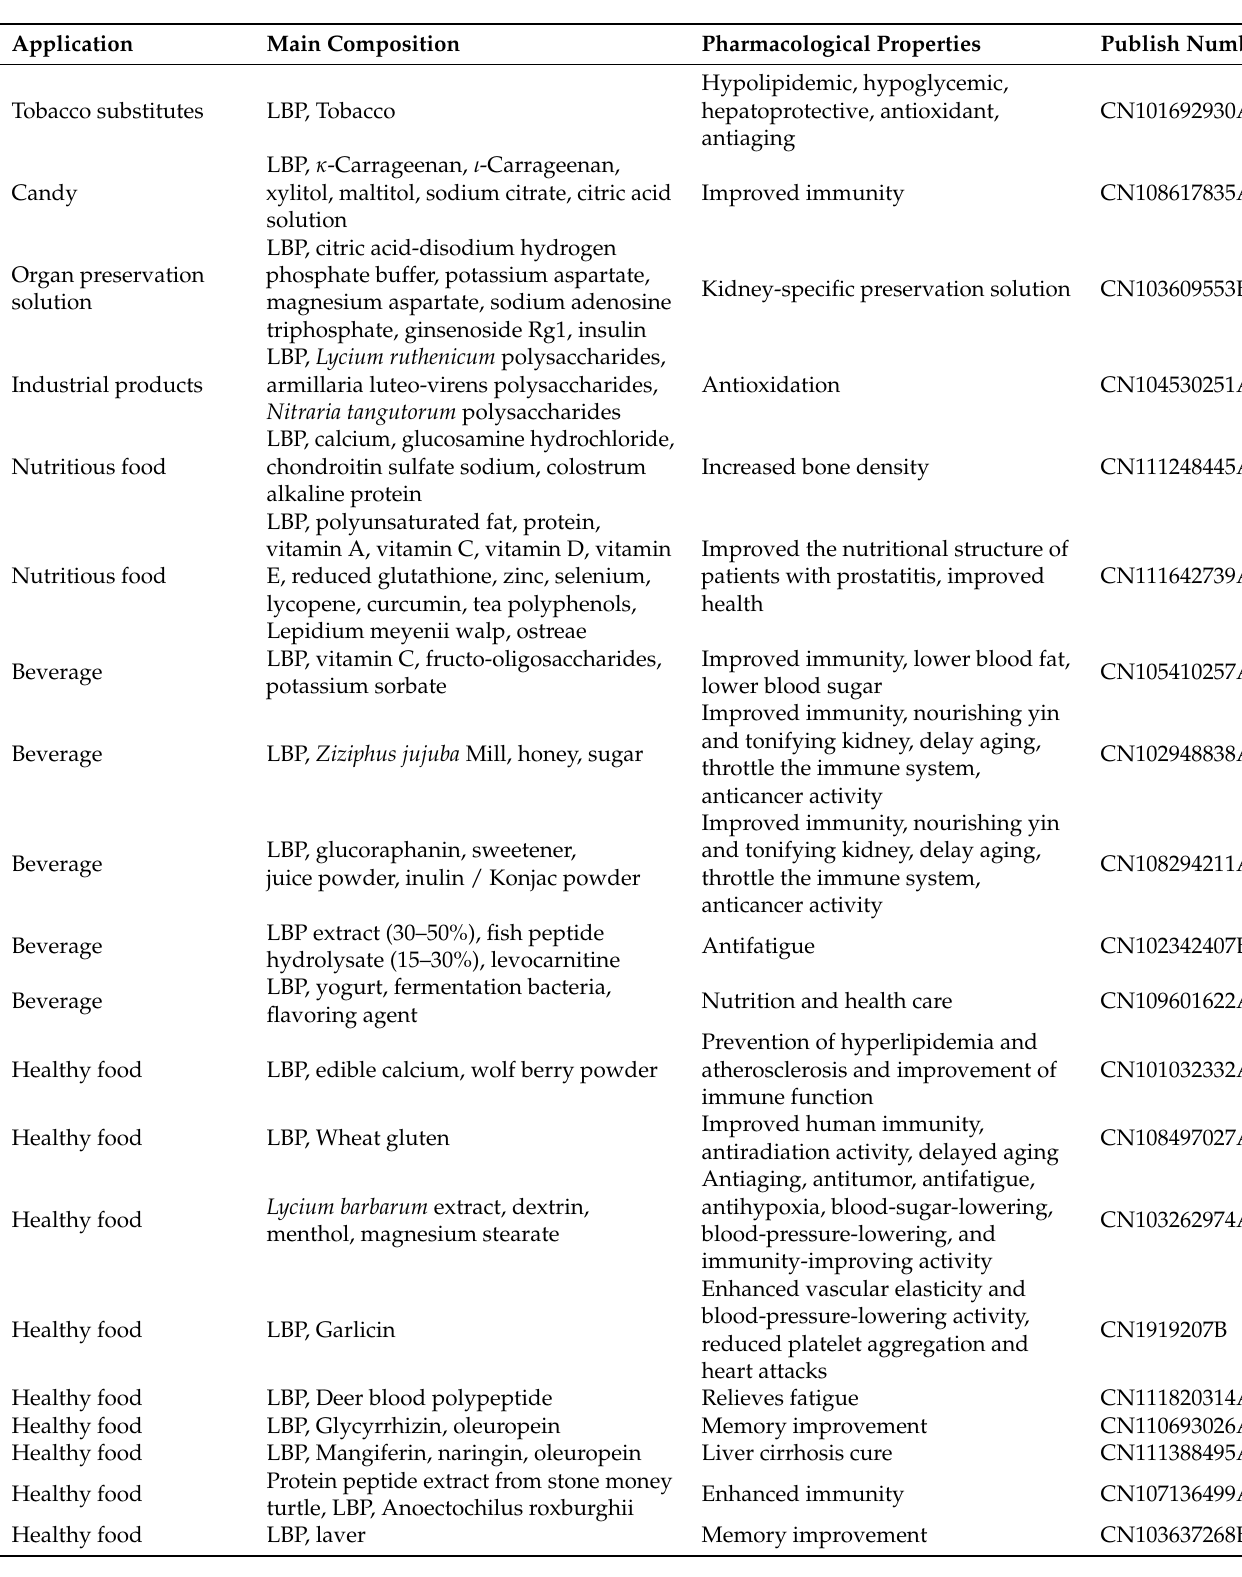
Table 5. Patent list of products containing LBP and their claimed pharmacological